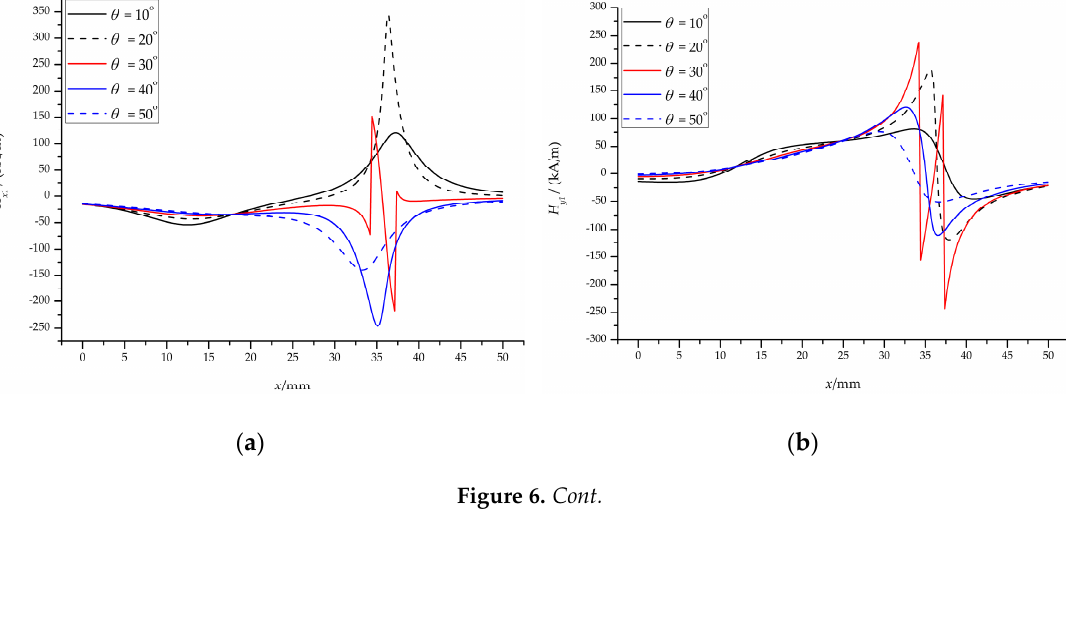
Figure 5. The results of vertical magnetic field: ( a ) The magnetic field strength and ( b ) the magnetic force acting on the particles at the center of the channel. Note that the residual magnetization of a single permanent magnet is 1.2